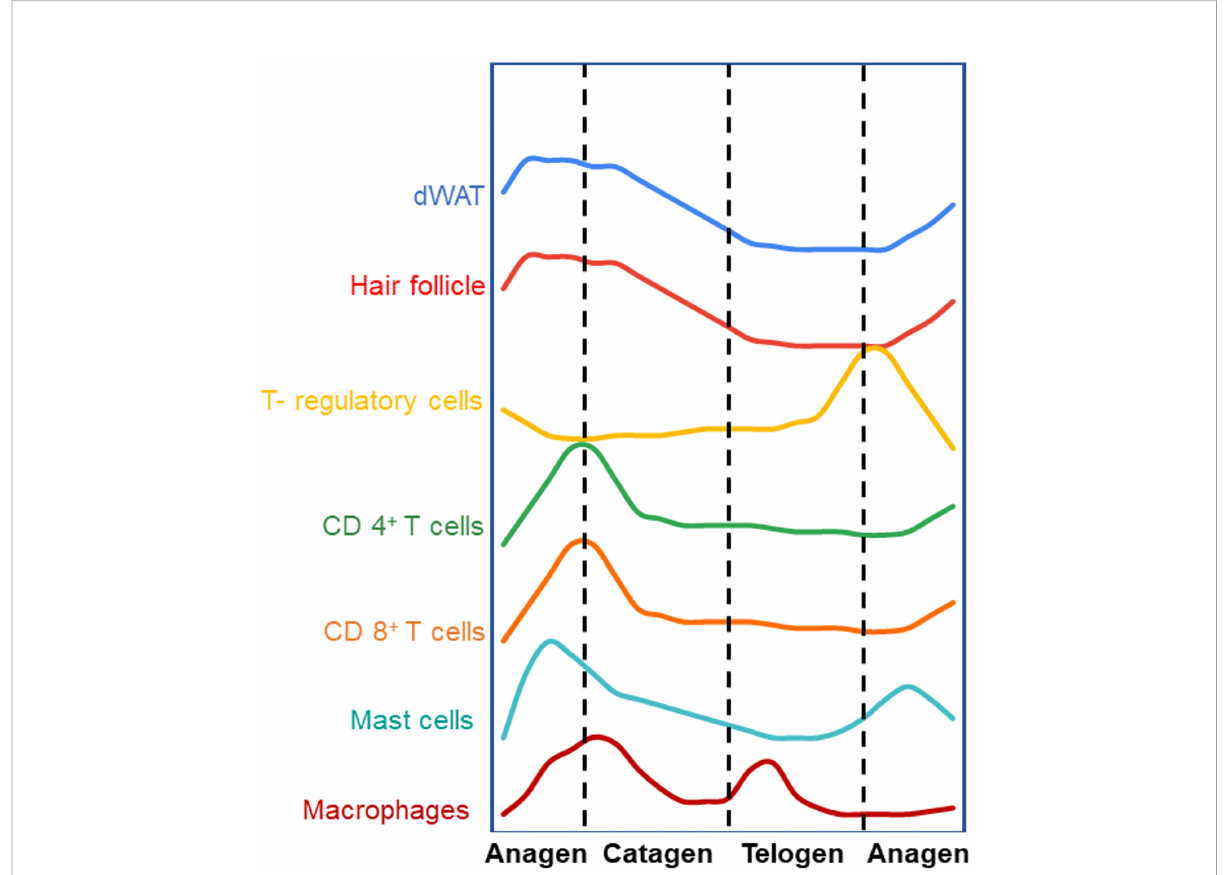
FIGURE 1 Different compartments of the skin cycle under homeostatic conditions (Arbitrary levels). The hair follicle is well known to undergo regenerative cycles of anagen (growth), catagen (regression) and telogen (resting phase). Immune cells and dermal white adipose tissue (dWAT) cycle synchronously with respect to different stages of hair follicle. Most of the immune cells follow a similar trend where they increase in number during anagen and decline with catagen and telogen. Interestingly, T-regs cycle in the opposite fashion – T-regs are more in number in the telogen phase than anagen or catagen. This could signify a possible regulatory relationship between these different cell types though mechanisms governing this cyclical behavior are yet to be de fi ned. (5 –